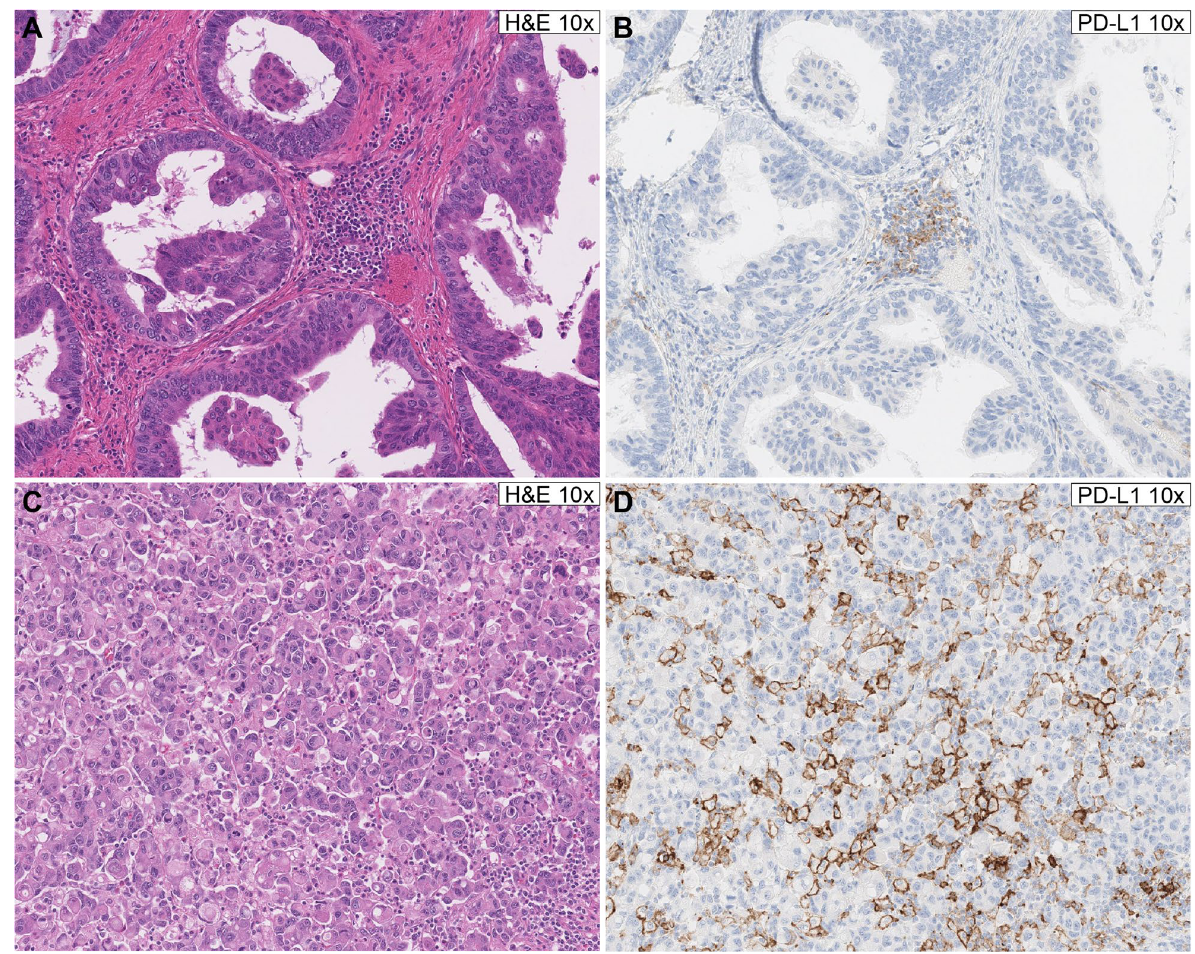
Fig. 4 PD-L1 expression status around the 5% TAP score cutoff. Top panel : PD-L1 negative case, TAP score <5% ( A H&E staining, B PD-L1 staining). Bottom panel : PD-L1 positive case, TAP score >5% ( C H&E staining, D PD-L1 staining). H&E hematoxylin and eosin, IC immune cells,